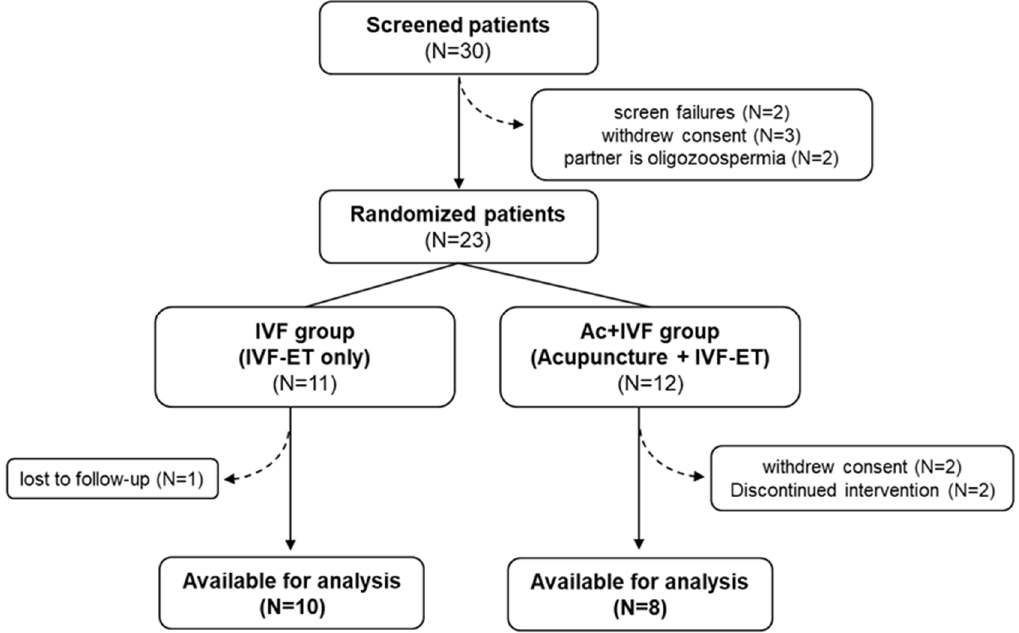
Figure 5. Flow chart of patient enrollment. Recruitment, follow-up, and dropouts over the course of study.